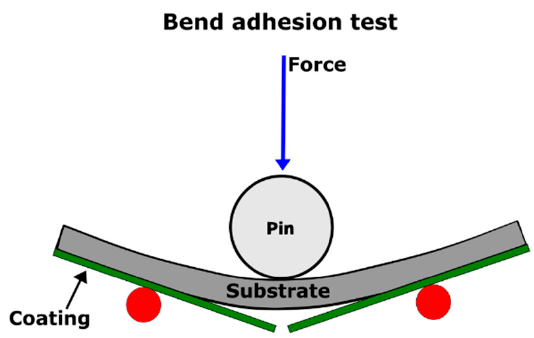
Figure 5. Adhesion bend test [64].